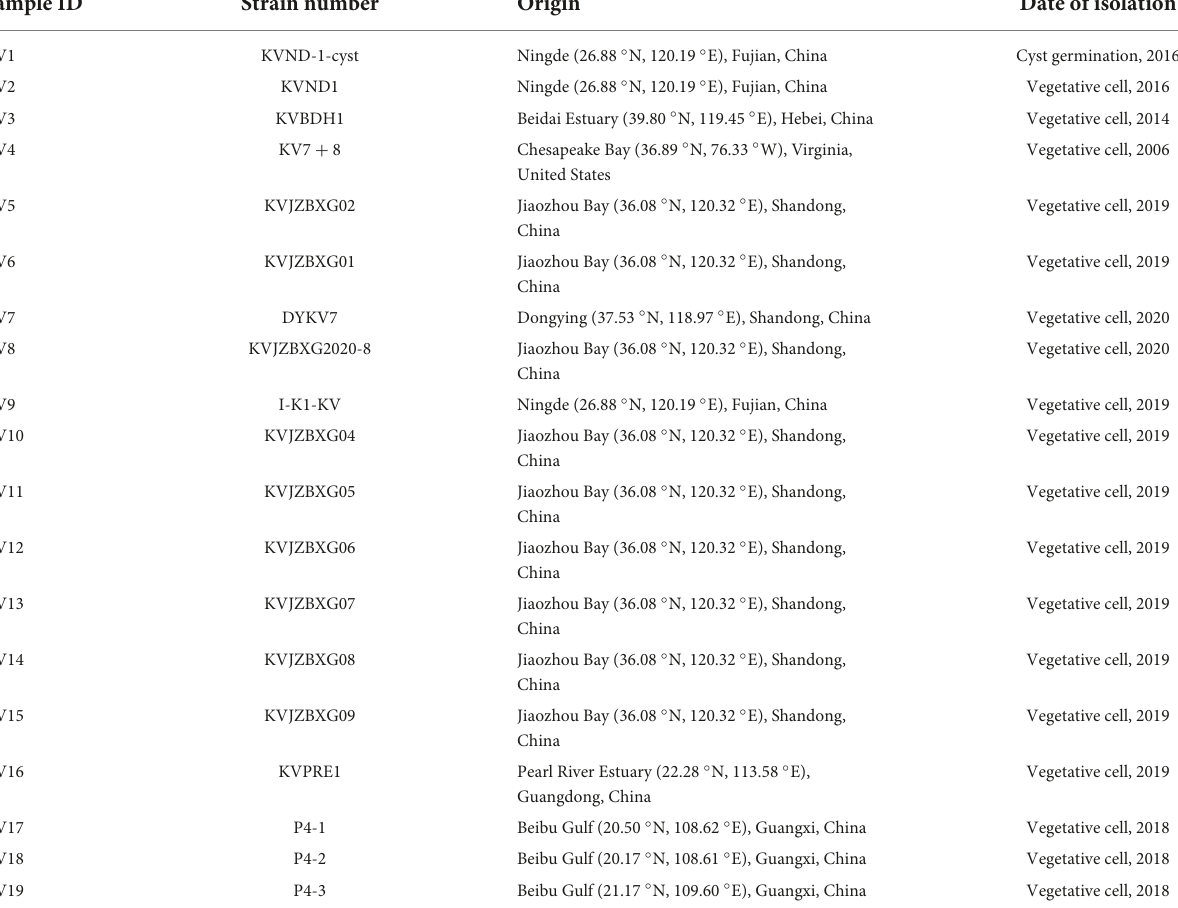
TABLE 1 Information on 19 clonal cultures of Karlodinium veneficum used in this